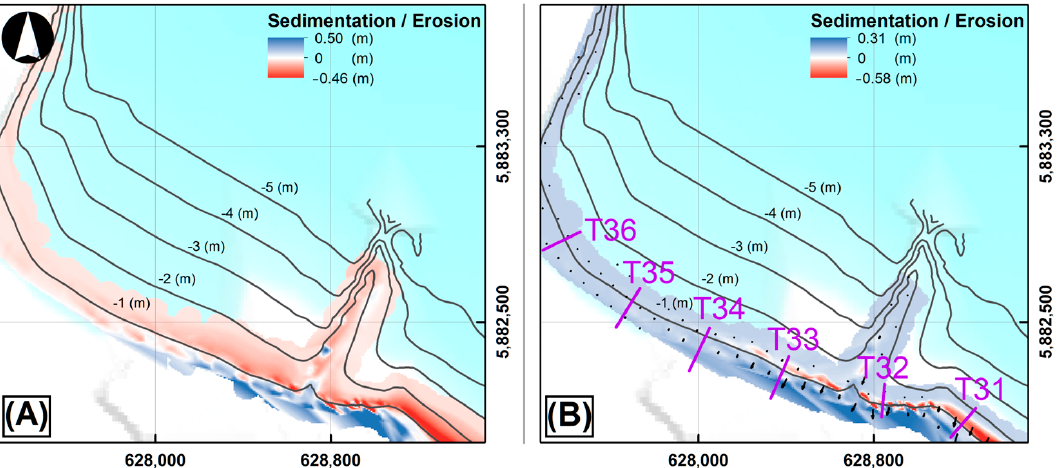
Figure 17. Morphological changes in Llico during: ( A ) winter and ( B ) summer, as in Figure 13. T31-T36 are control transects at Llico beach.